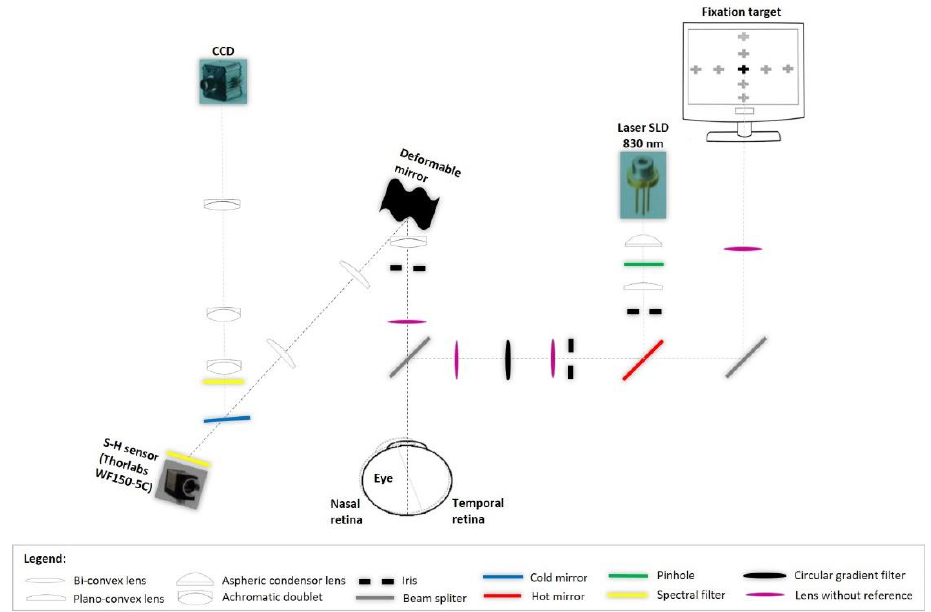
Figure 1. Simplified schematic representation of the experimental procedure. A laser super luminescent diode (SLD) was used to generate a point source, which reflects on retina and propagates out of the eye; the wavefront being sampled at the sensor. A fixation target was presented on a monitor. The configuration of the optical system allows a target vergence close to zero on the ocular surface and that angular deviation in relation to the eye was characterized by the angular amplification of the optical system between the monitor and the eye. The position of the target was controlled by software and could be moved to different positions.